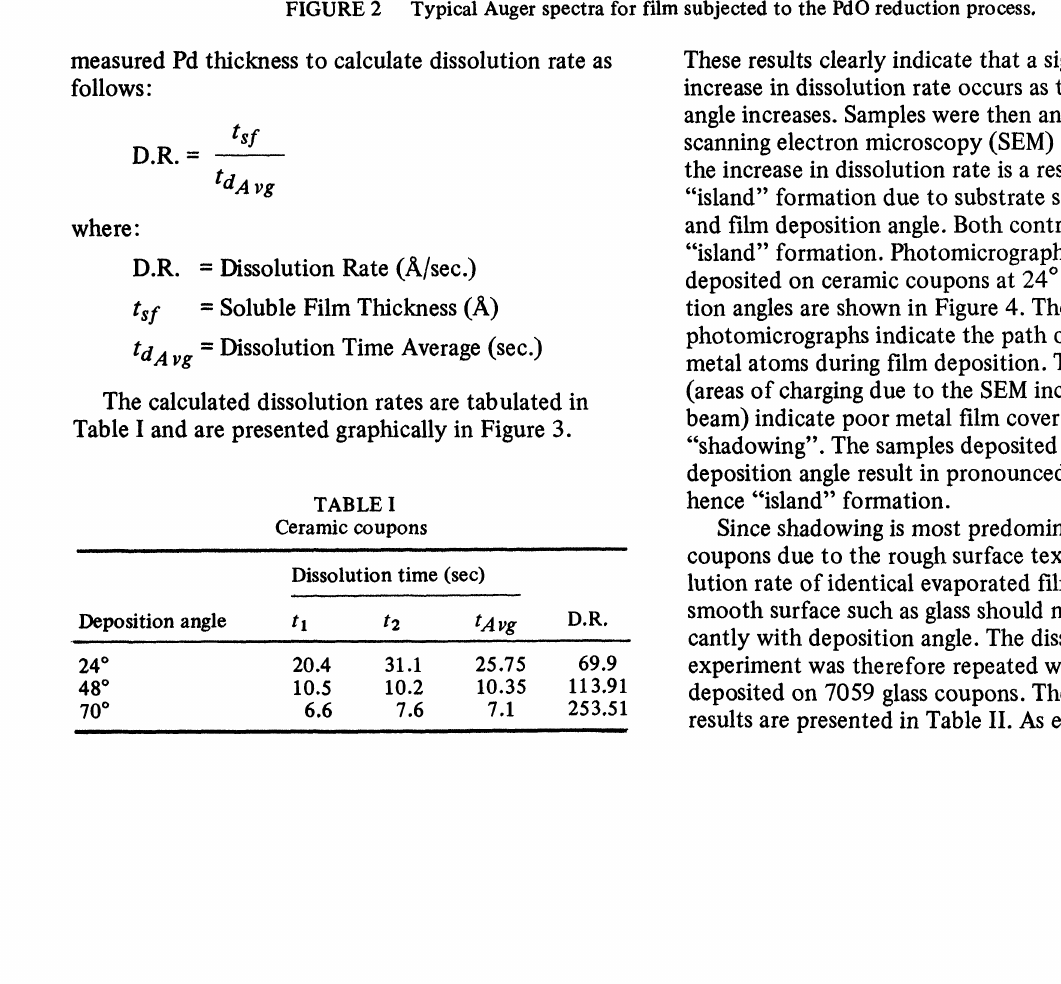
800 t2OO 16OO ELECTRON ENERGY (eV) FIGURE 2 Typical Auger spectra for film subjected to the PdO reduction